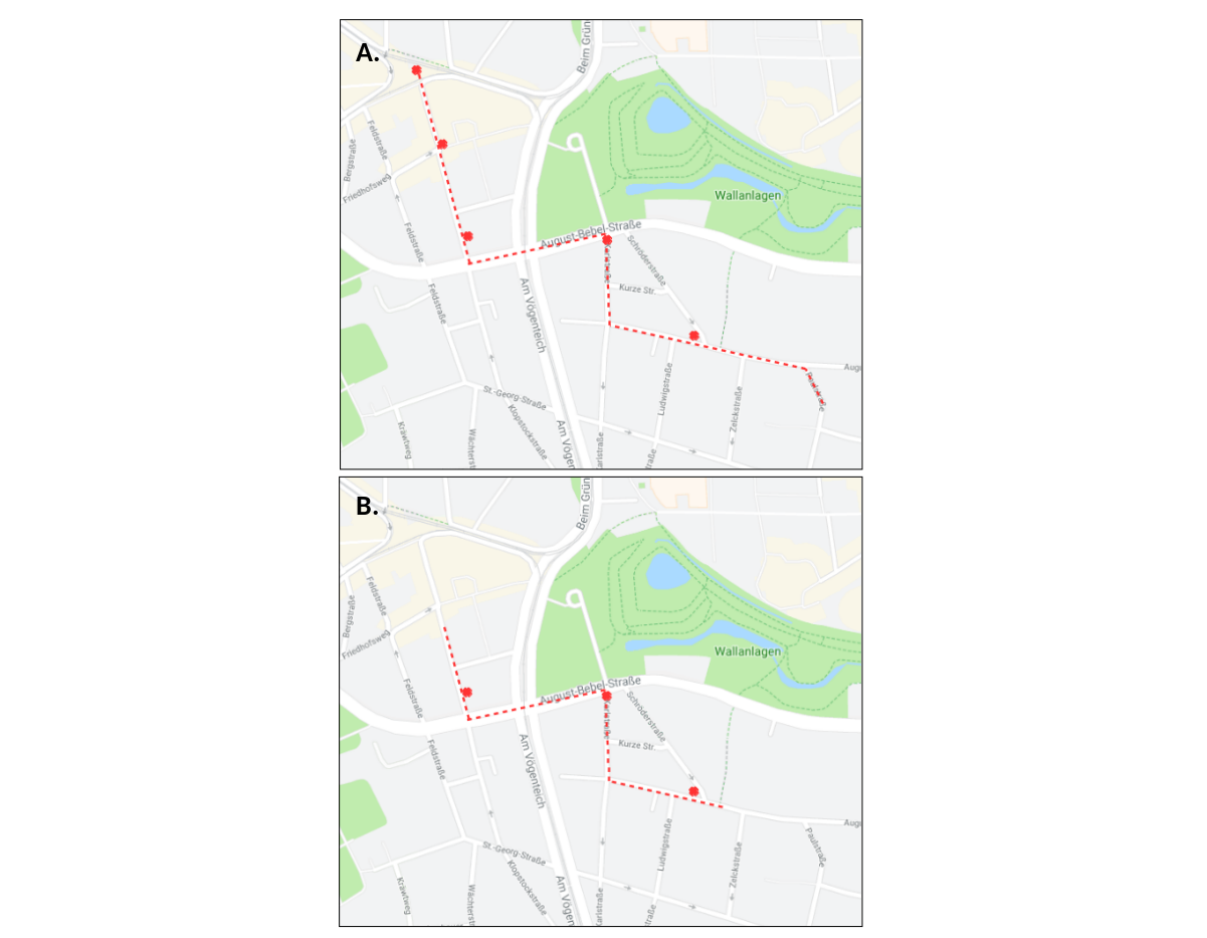
Figure 3. Map of the routes of (A) cognitively healthy older participants and (B) patients with dementia. Red crosses denote locations where the environment is changed in the experimental run. The environment is unchanged for the patients with dementia; however, the route is shortened (image: Google